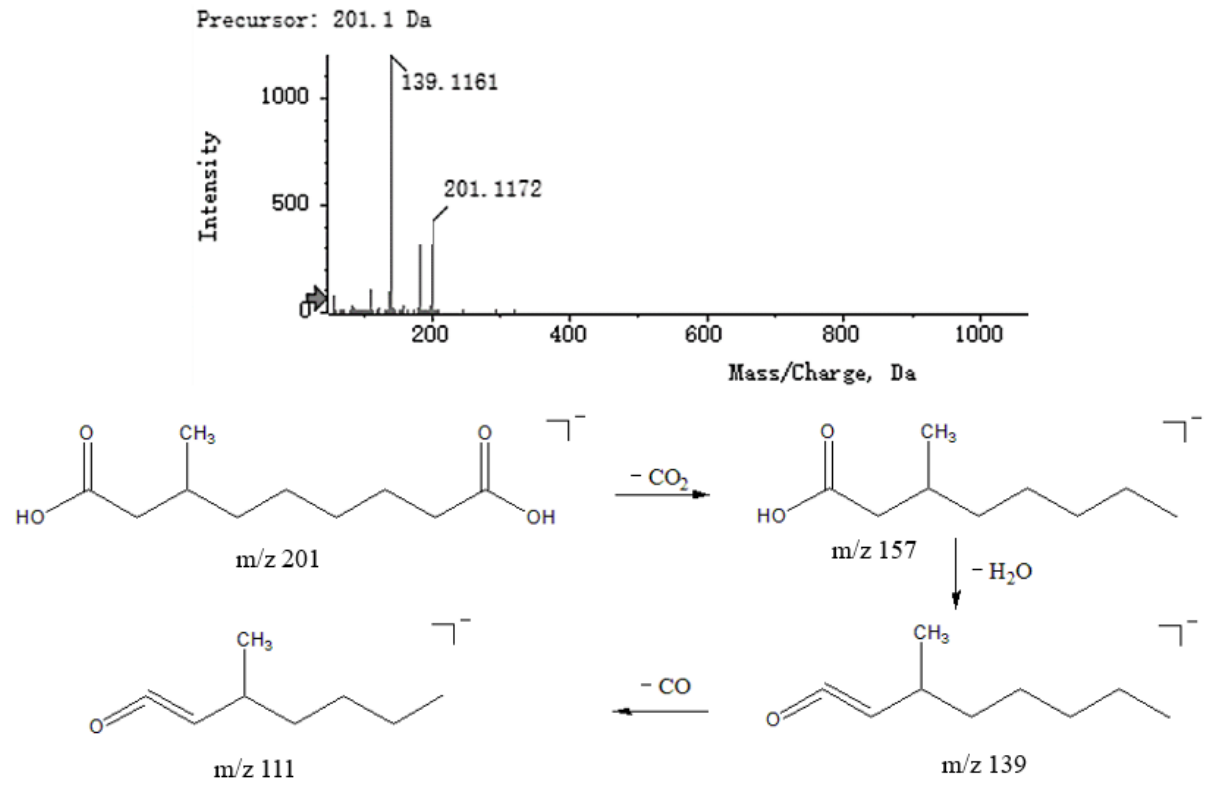
Figure 7. MS 2 spectra of 3-methylnonanoic acid and speculated fragmentation pathways.